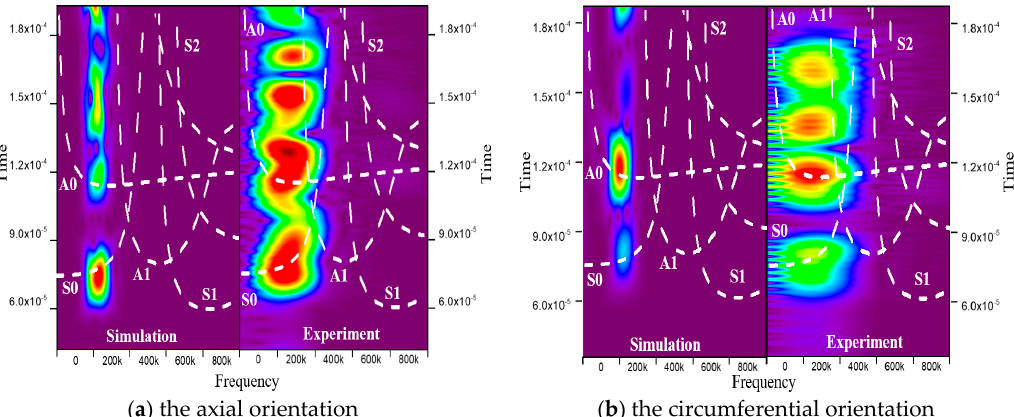
Figure 7. Time-frequency representation of the guided wave signals extracted from the simulation and experiment.